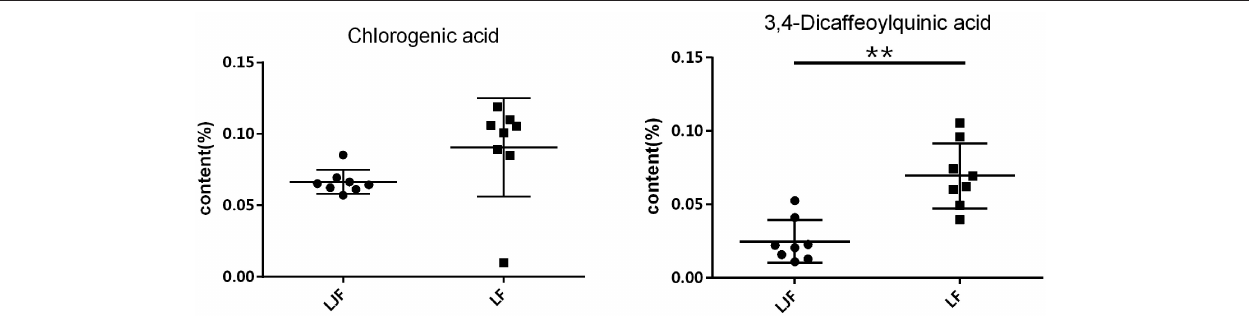
FIGURE 7 | The contents of Chlorogenic acid and 3,4-Dicaffeoylquinic acid in Lonicerae Japonicae Flos and Lonicerae Flos. The points on the scatter plots represent the amounts of Chlorogenic acid or 3,4-Dicaffeoylquinic acid in batches of flower bud extracts. Error bars represent mean ± s.e.m. From a two-tailed unpaired Student’s t -test, ** P < 0.01